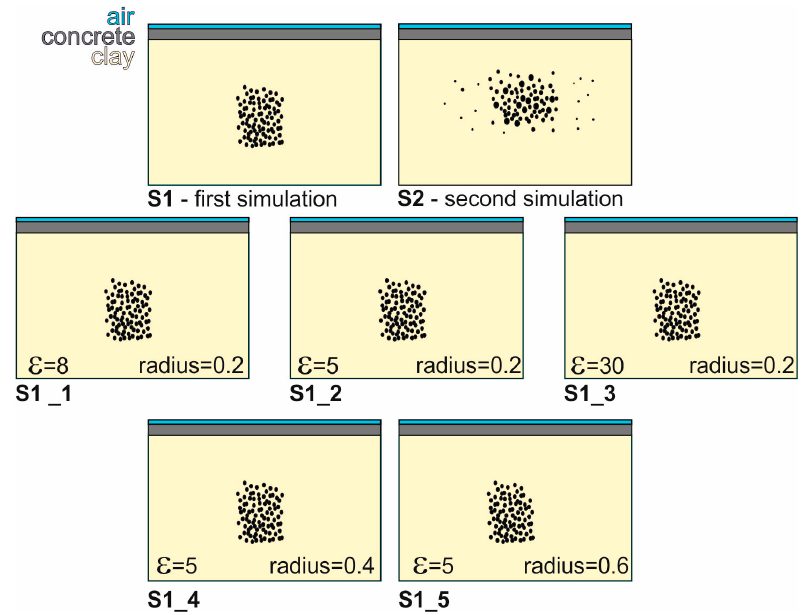
Figure 7. The two simulations (S1 and S2) based on different particles distribution. S1_1, S1_2, S1_3, S1_4 and S1_5 represent the five sub-cases considered in the first simulation (S1).